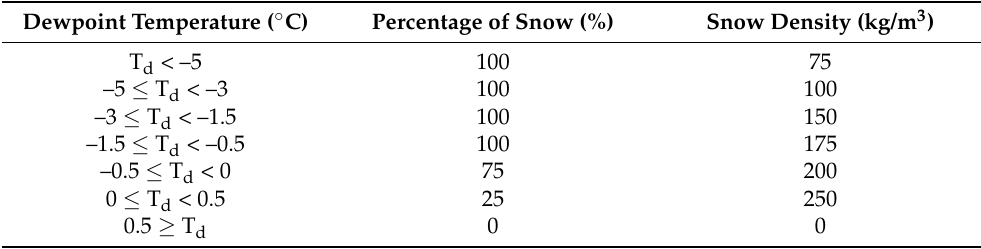
Table A2. Precipitation partitioning table and fresh snow density based on dewpoint temperature (after Susong et al. [53]).